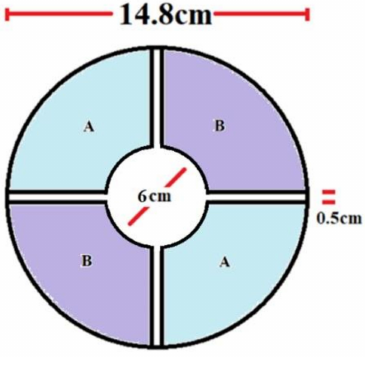
Figure 4. Field mill sensor top view. The main parameters of the field mill sensor appear in Table 1. Table 1. Parameters of the electric field mill sensor used for measurements. Parameter Value Unit Number of vanes,